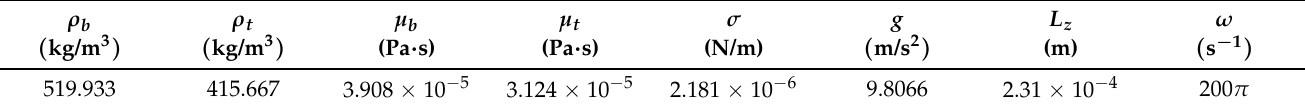
Table 1. Physical parameters defining linear test cases.